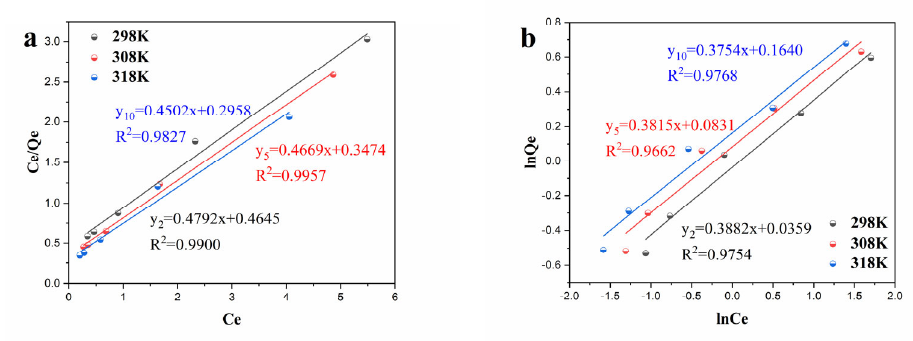
Figure 7. Curve of Langmuir ( a ) and Freundlich ( b ) isotherm fitting for fluoride adsorption on